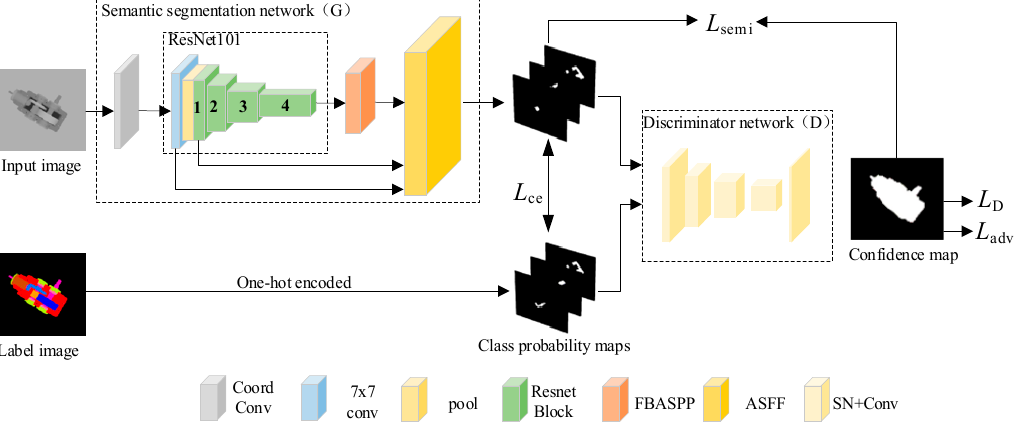
Figure 1. The overall structure of the network.